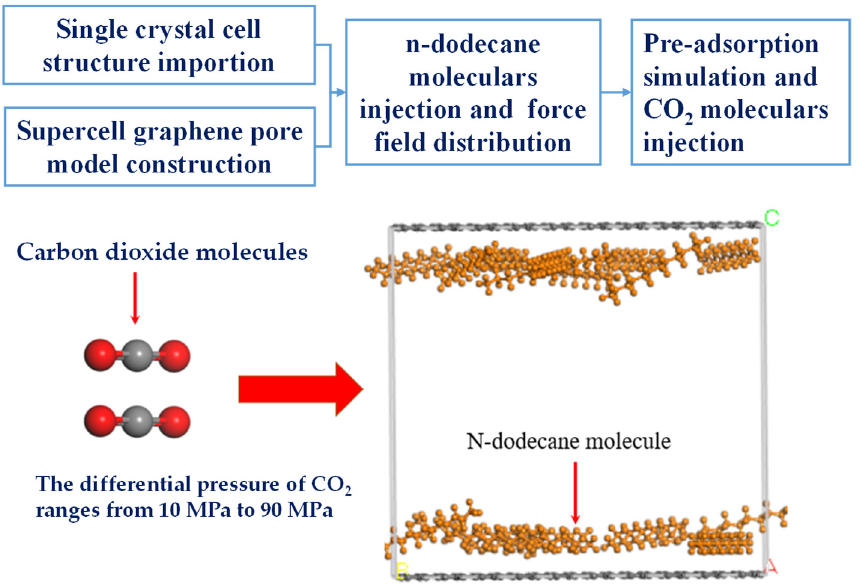
Figure 1. Schematic diagram of n-dodecane adsorbed in pores under different injection pressures of CO 2. (A, B and C respectively represent different coordinate